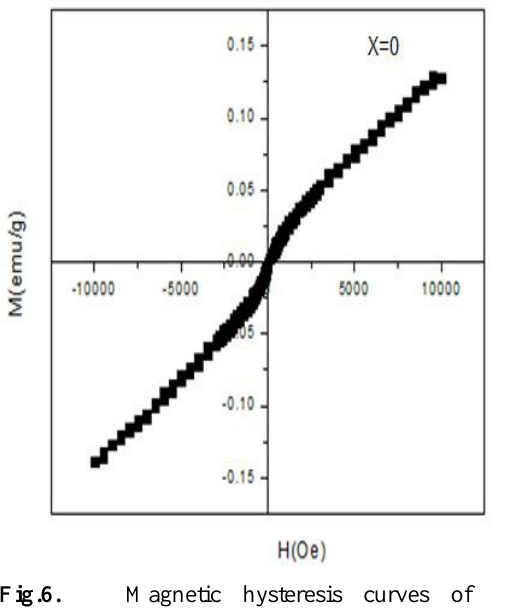
Fig. 5 . M-H curve of NiO nanoparticle before calcinations.